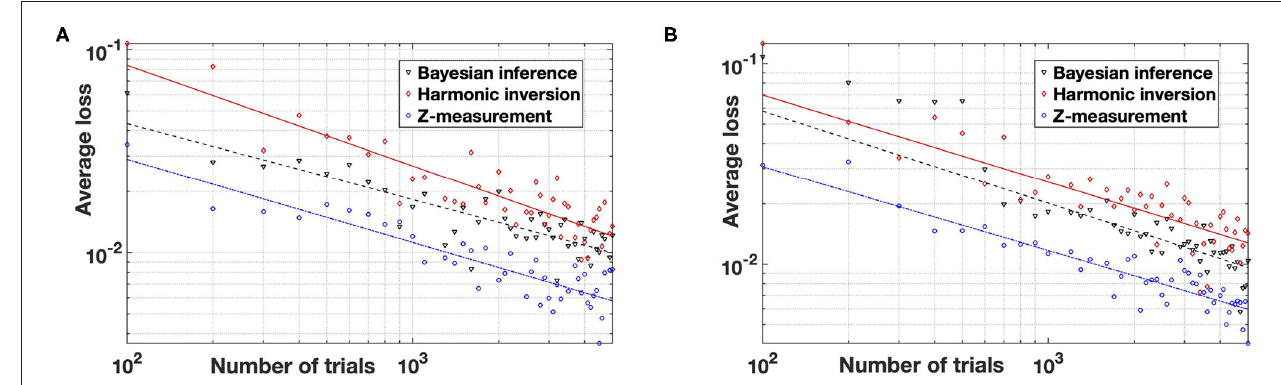
FIGURE 3 | Loss function vs. number of measurements of the quantum computer (trials) in both 4-orbital model and 8-orbital model. Red diamonds, black triangles, and blue circles are drawn from harmonic inversion, Bayesian inference and Z -basis measurement respectively. (A) 2 Electron 4 orbital case. (B) 2 Electron 8 orbital